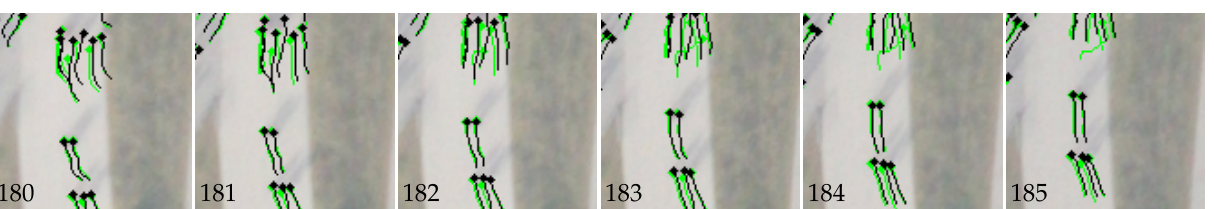
Figure 8. A failure case by Stacked-DCFNet on the sequence “AA_Walking_02”. The tracking results and ground truth are depicted in green and black, respectively.